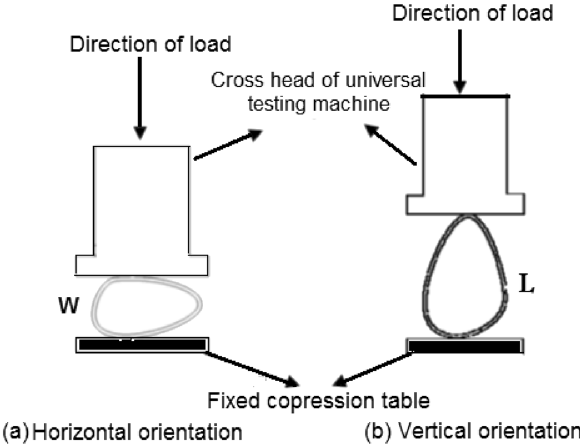
Figure 1. Crushing load testing machine as described by Khodabakhshian et al. 14